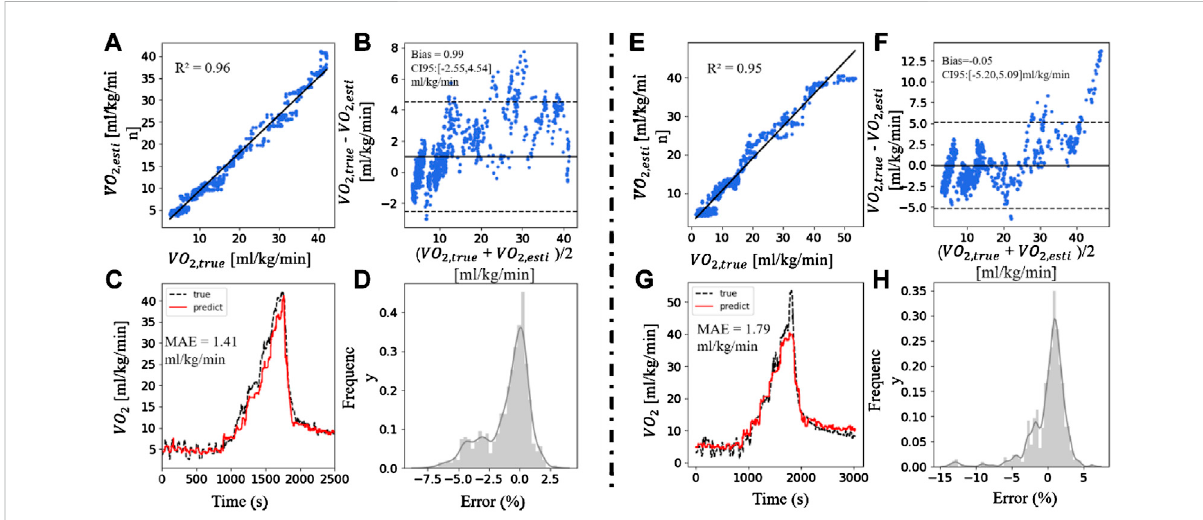
FIGURE 5 A good and a bad case. (A,E) The scatter plot of VO 2 , esti and VO 2 , true . (B,F) The Bland-Altman plot of VO 2 , esti and VO 2 , true . (C,G) Real-time VO 2 , esti and VO 2 , true . (D,H) The error distribution of VO 2 , true and VO 2 , esti